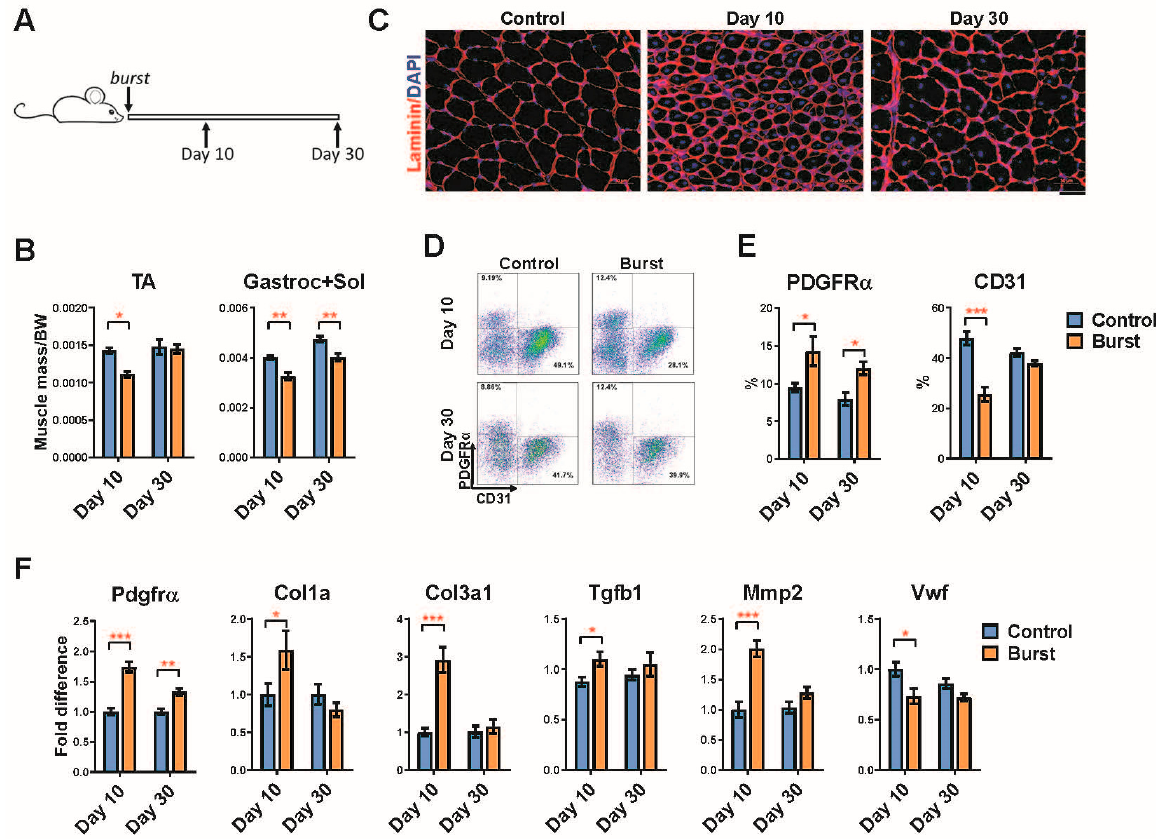
Figure 4. A burst of DUX4 is sufficient to induce long term FAP infiltration. ( A ) Scheme of doxycycline burst induction protocol in iDUX4pA;HSA mice. Mice at 4 weeks of age received a single dose of doxycycline (100 mg/kg, i.p.). Analyses were performed 10 and 30 days post-DUX4 induction. ( B ) Muscle mass normalized to the body weight from iDUX4pA;HSA mice 10 and 30 days after the burst induction. Data represent mean ± SEM, * p < 0.05, ** p < 0.01 by two-way ANOVA, n = 5. ( C ) Representative immunofluorescence images for laminin (red) and nuclei (DAPI, blue) in quadriceps at 10 or 30 days post-burst. Scale bar 50 μ m. ( D ) Representative FACS profiles of FAPs (CD45 neg /PDGFR α +) and endothelial cells (CD45 neg /CD31+) in skeletal muscle at 10 and 30 days post-burst. ( E ) Summary of the FACS analyses on the samples represented in ( D ). Data represent mean ± SEM, * p < 0.05, *** p < 0.001 by two-way ANOVA, n = 4. ( F ). RT-qPCR for genes related to fibrosis and endothelial cells in gastrocnemius from iDUX4pA;HSA mice at the time of analyses. Data represent mean ± SEM, * p < 0.05, ** p < 0.01, *** p < 0.001 by two-way ANOVA, n = 5.